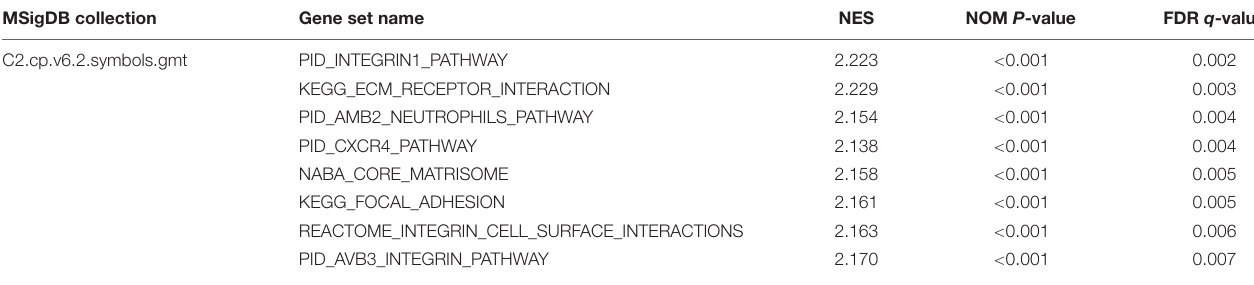
TABLE 4 | Gene sets enriched in CD39 phenotype